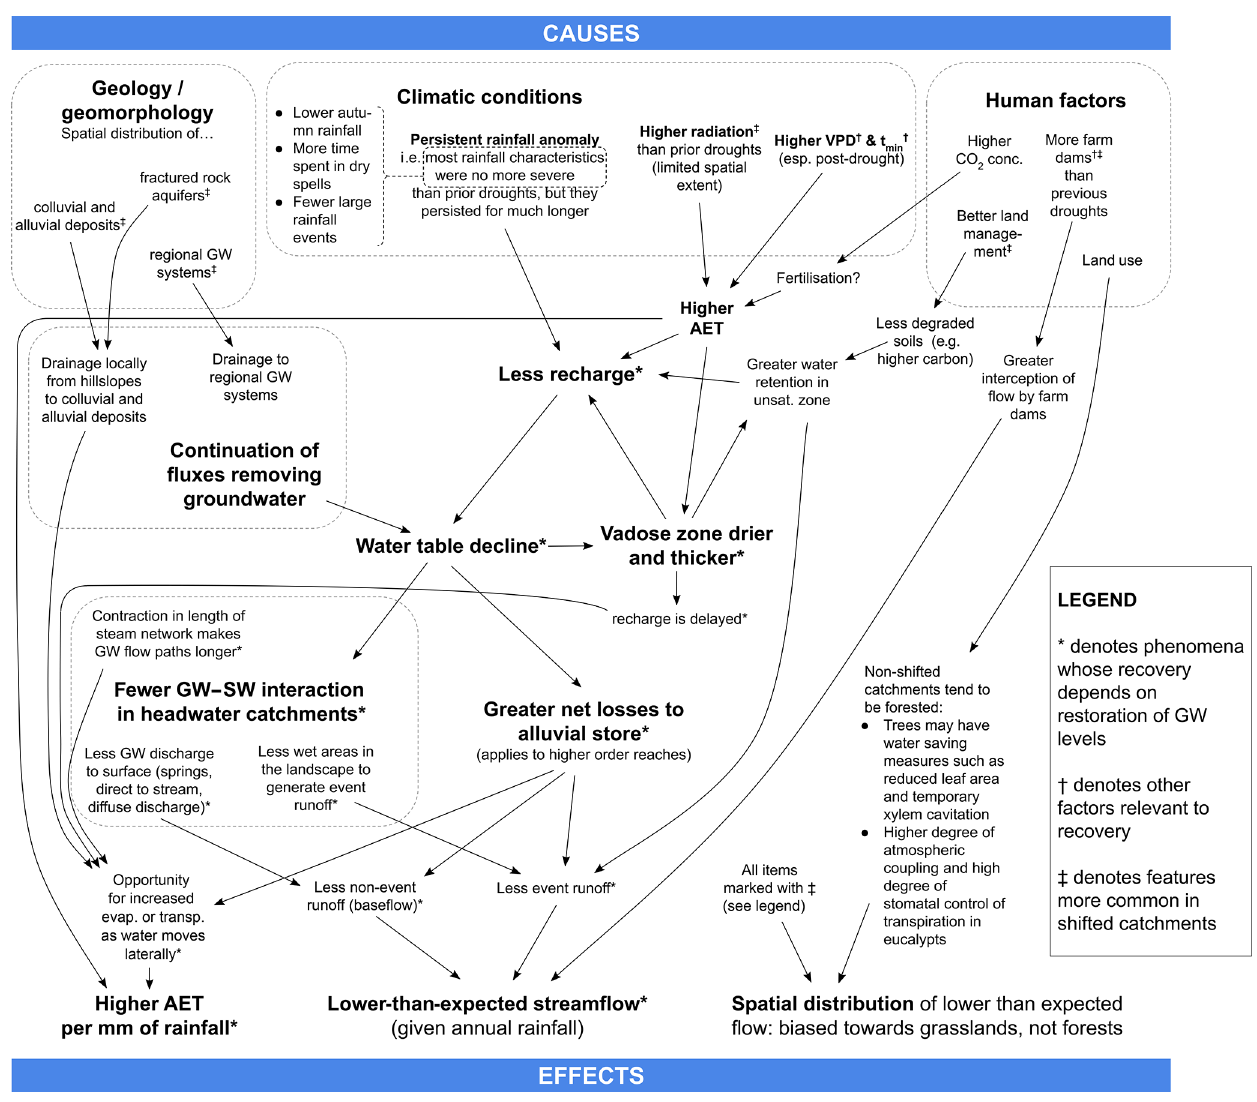
Figure 10. Chain of causality from cause (top) to effect (bottom) for plausible hypothesised process explanations. Pure causes are at the top and pure effects are at the bottom, while those in-between are a mixture (i.e. effects of some things and causes of